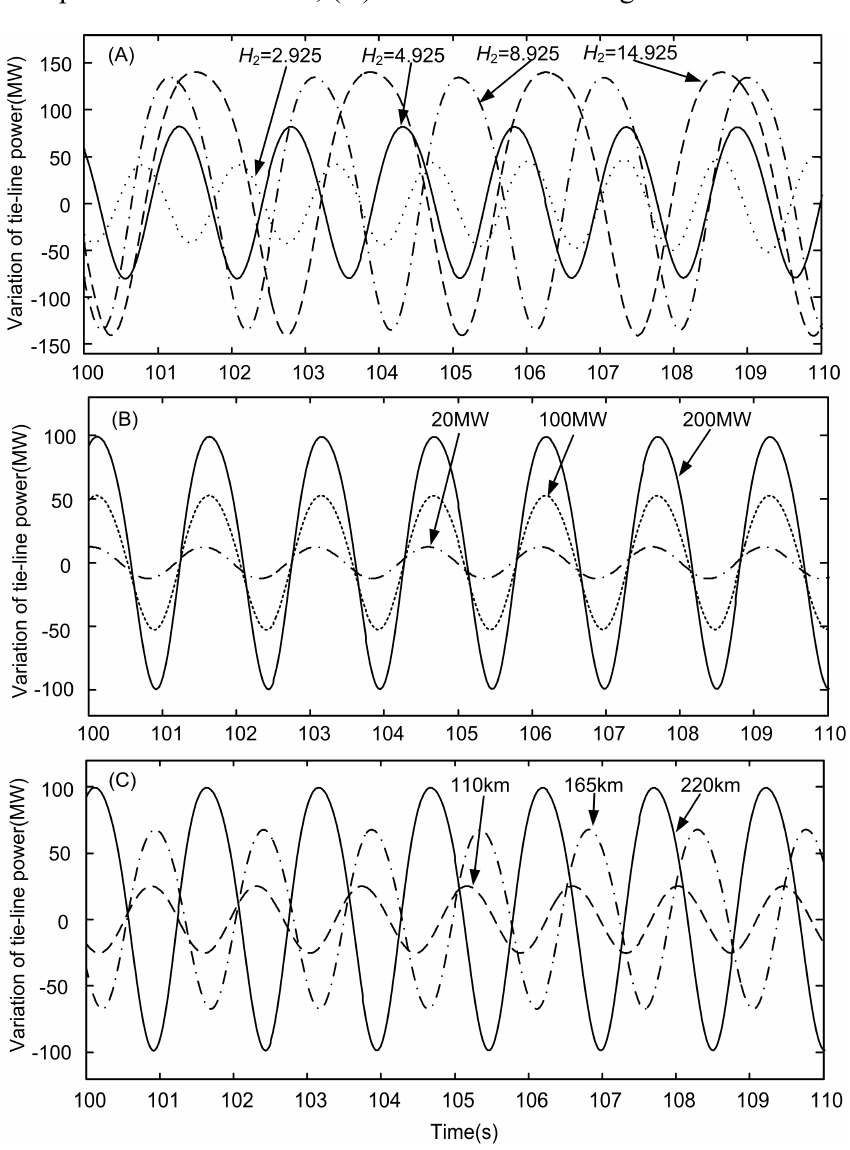
Figure 9. Tie-line power oscillations with ( A ) different inertias of integrated subsystem; ( B ) different capacities of wind farm; ( C ) different tie-line